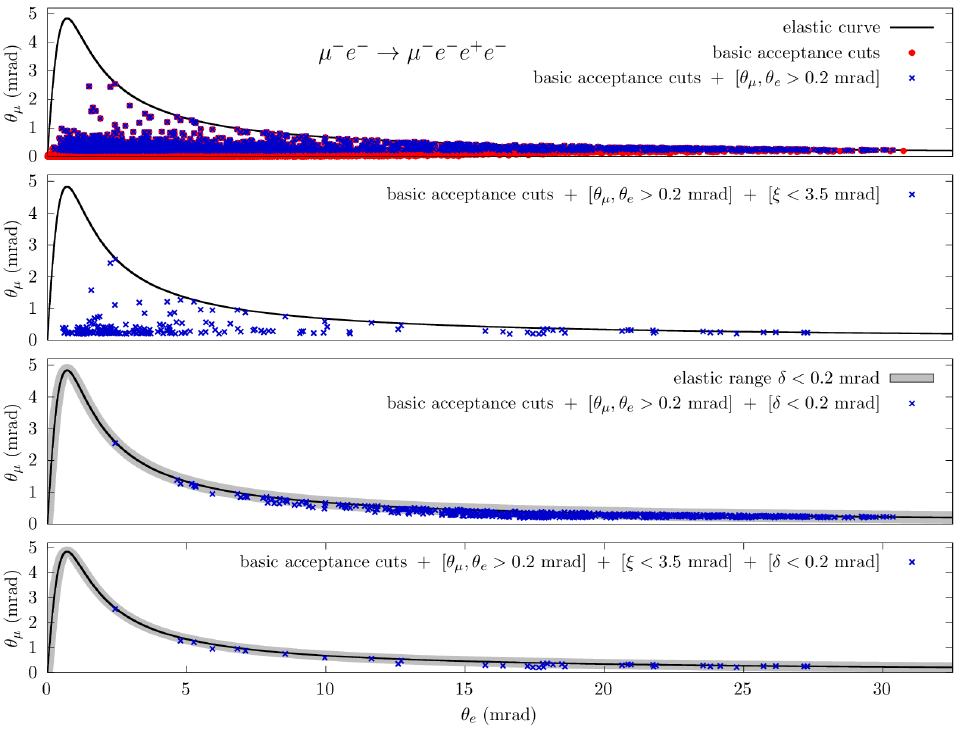
Figure 22. Scatter plot of ( θ e , θ µ ) points for 5 · 10 5 µ − e − → µ − e − e + e − simulated events.